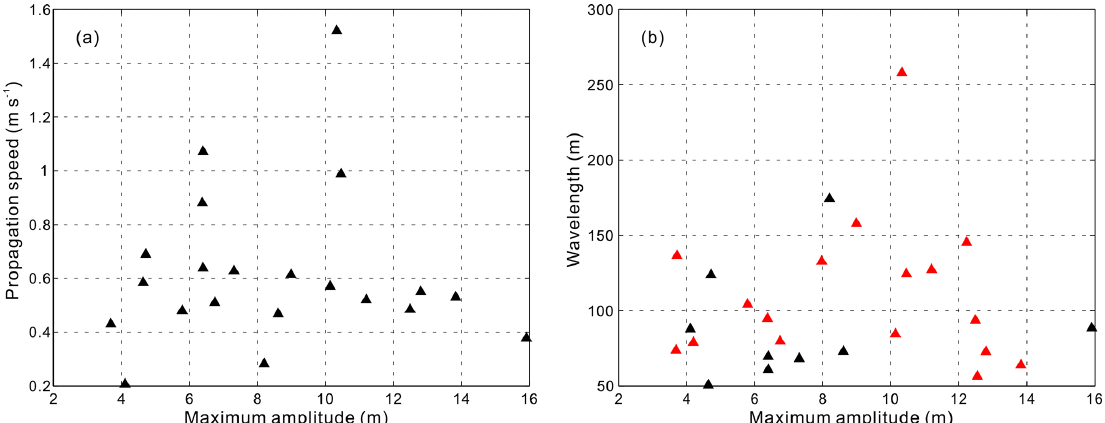
Figure 9. (a) Relationship between the propagation speeds and the maximum amplitudes of the mode-2 ISWs observed in the study area. (b) Relationship between the wavelengths and the maximum amplitudes of the mode-2 ISWs observed in the study area. The black and red triangles in panel (b) denote the ISWs on the survey lines in the SW–NE and NE–SW directions, respectively.